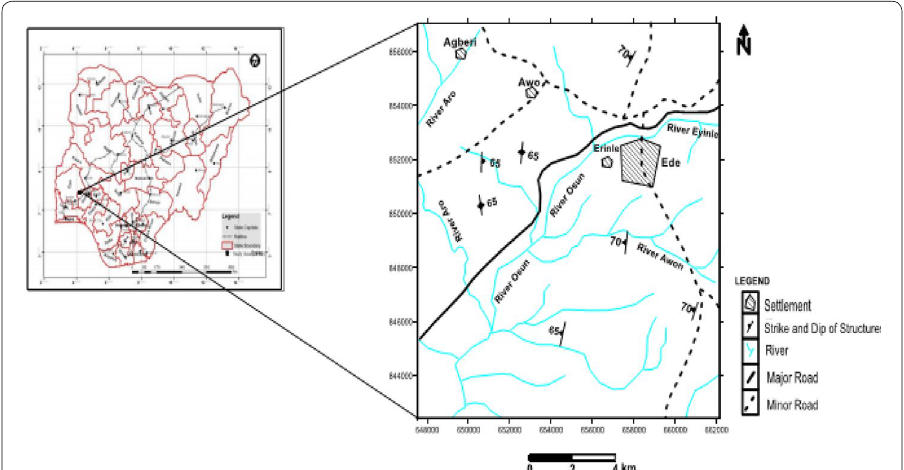
Fig. 1 Location map of the study area showing drainage pattern, Erinle (modified from Iwo Sheet 60 NGSA,